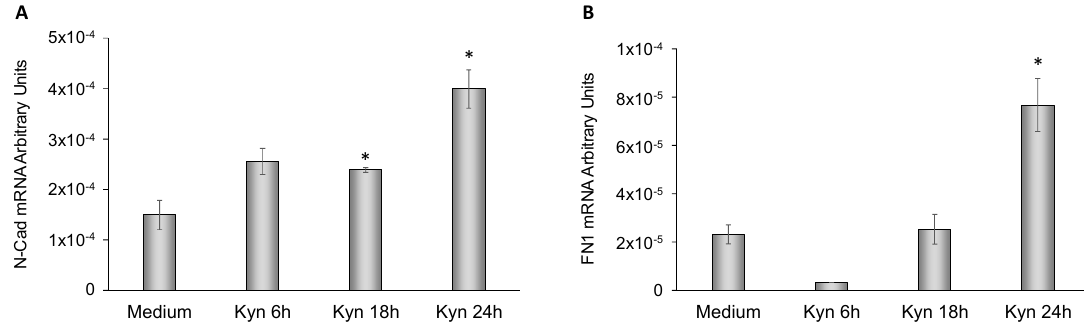
1.6 fold at 18 h, p = 0.03; 2.7 fold at 24 h, p = 0.009. Fibronectin-1: 3.3 fold at 24 h, p = 0.01) (Figure 9A,B).